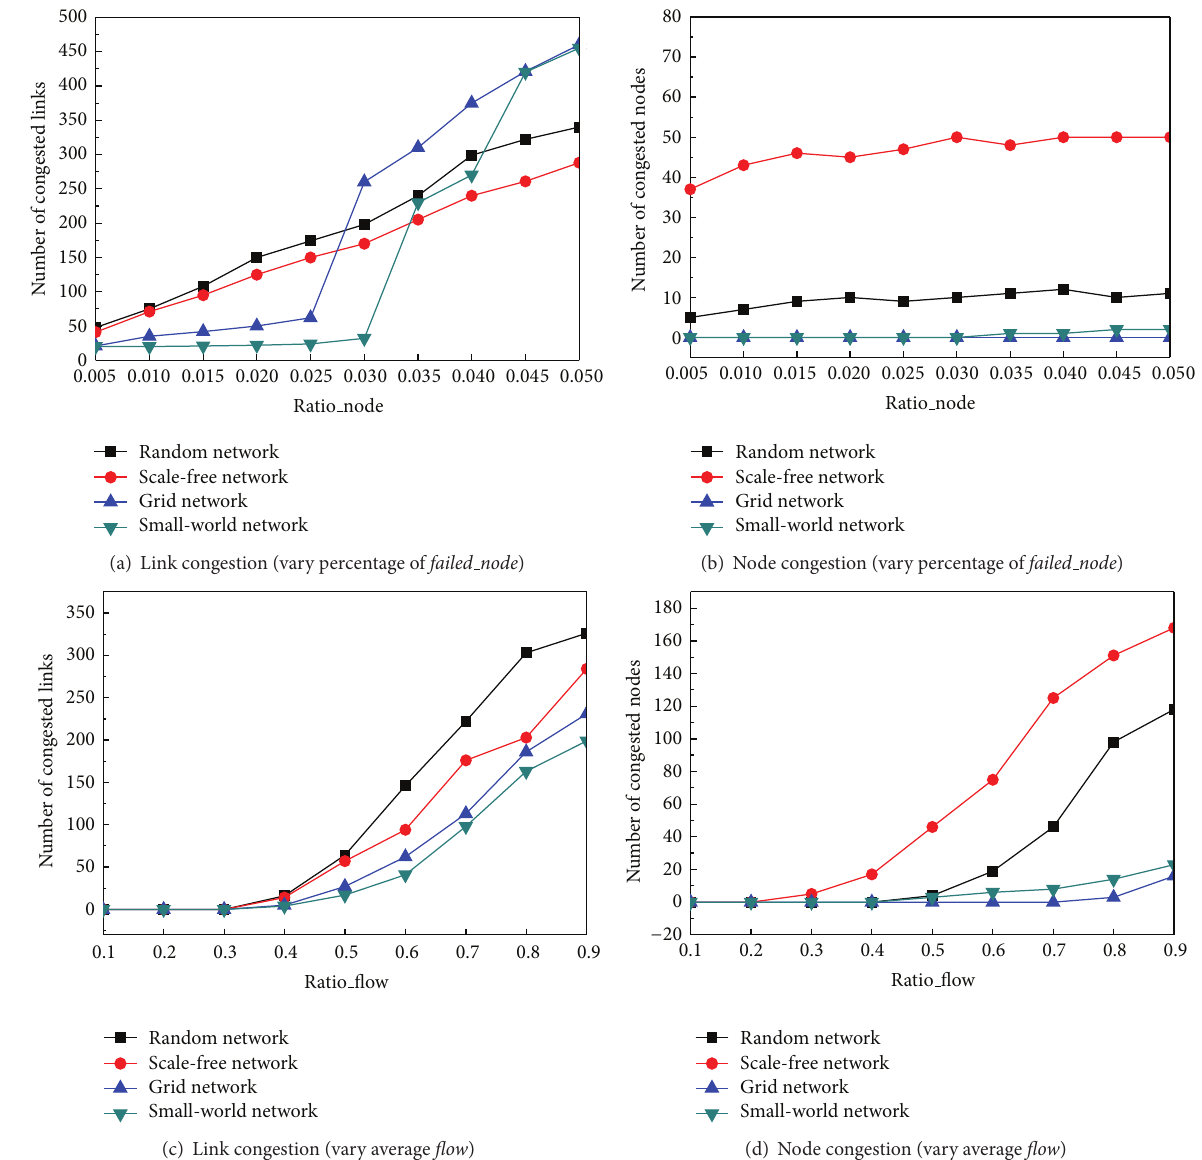
Figure 4: Congestions from node failure recovery by varying Ratio node and Ratio flow